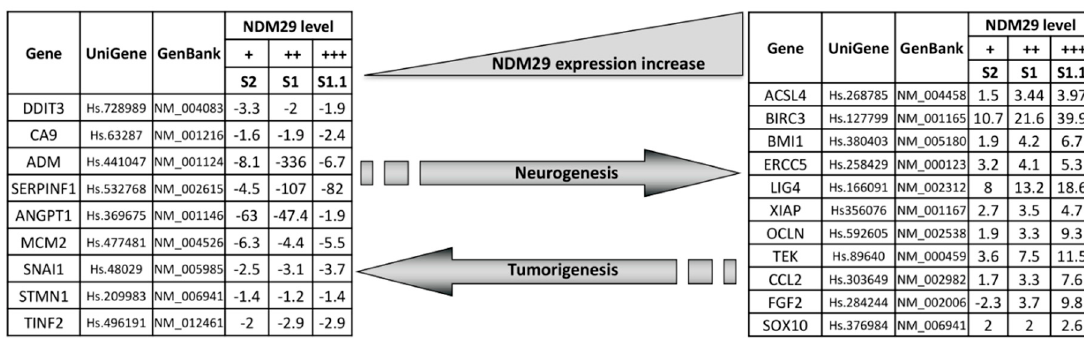
Figure 2. Di ff erent expression of genes associated with tumorigenesis or Figure 2. Different expression of genes associated with tumorigenesis or neurogenesis.